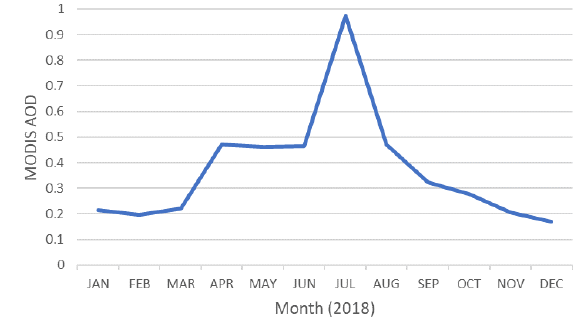
Figure 5 . Monthly average of MCD19A2 AOD over the study area in